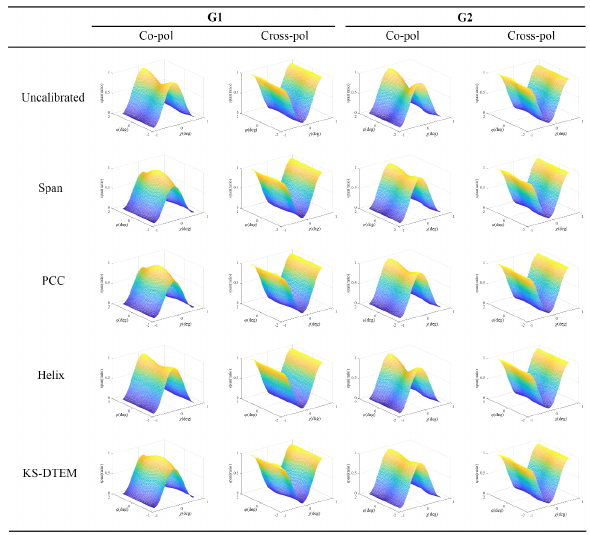
Figure 5 . Co-pol and cross-pol response diagrams of